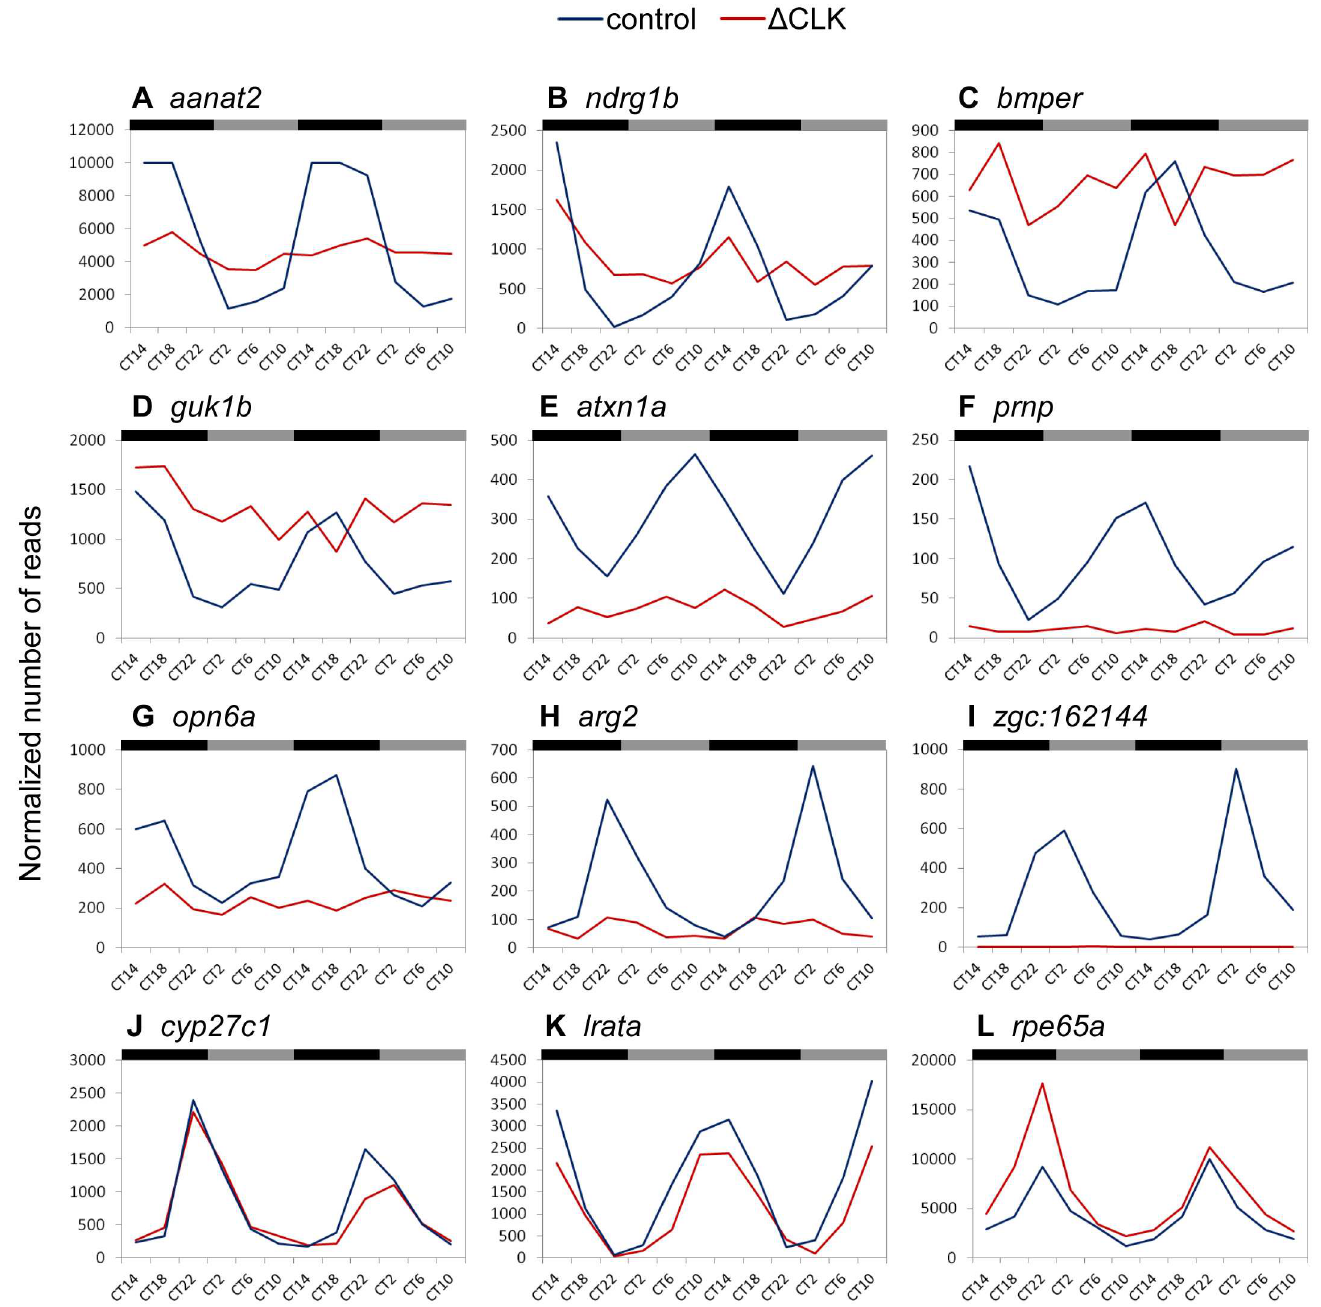
Fig 5. Diverseeffects of Δ CLK on expression profiles of clock-controlled genes in the pineal gland. Representative examplesof expression profilesof CCGs in the pinealgland of control Tg( aanat2 :EGFP) fish (control; blue trendline)comparedwith the expression profilesof these genes in the pinealglandof Tg( aanat2 :EGFP- Δ CLK) fish ( Δ CLK; red trendline).Black and gray bars denotesubjectivenight and day, respectively.CT, circadian time. While the majority of CCGs became arrhythmic (A–I), a few maintained their circadianprofile in the Tg( aanat2 :EGFP- Δ CLK) pinealgland (J–L). For some of the CCGs that became arrhythmic in the Tg( aanat2 :EGFP- Δ CLK) pinealgland the overall basal expressionlevels remainedrelatively intermediate or high (A–D), whereasfor others the expressionwas down-regulated (E–H) or abolished